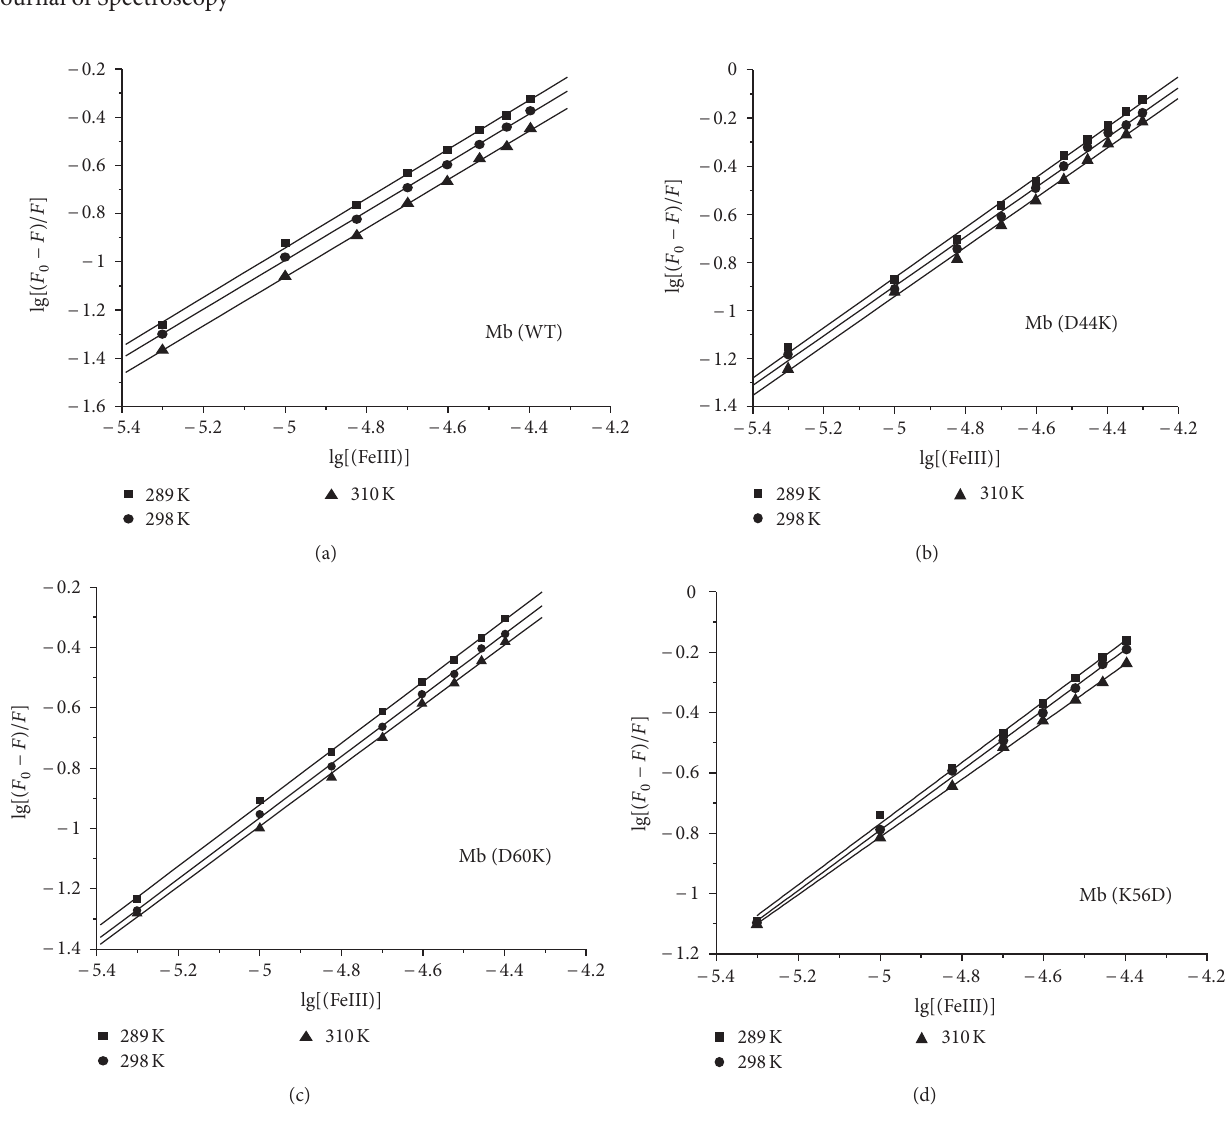
F 5: Double-lg plot at different